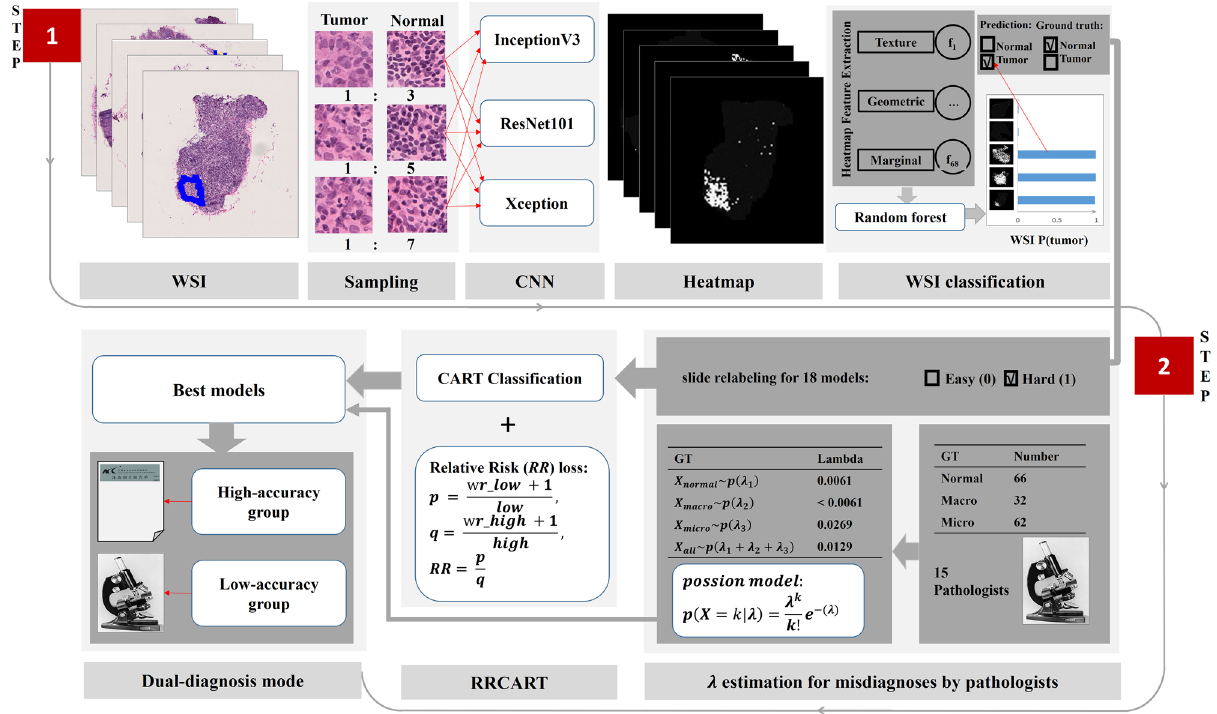
Figure 1. Overview of the Expert-DNN framework presented in this study. See Materials and Methods for complete details. There was two steps in this framework. In step 1, the patch-DNN workflow includes patch and WSI classification. Patches were extracted from tumor and normal regions of WSIs and as input data for DNN training. Patch coordination and probability generated by the model were then used for heatmap construction. A machine learning model (random forest) was trained based on the features extracted from the WSI heatmap and given a WSI-level prediction. The three sampling ratios (1:3, 1:5 and 1:7) correspond to three DNNs (InceptionV3, ResNet101 and Xception), respectively, and the experiment is repeated once. Therefore, we can obtain 18 patch-DNN models. In step 2, a Poisson distribution for the pathology experts and a RRC ART were FSs. The patch-DNN prediction result was compared with the ground truth to relabel the WSI as either easy (0) or hard (1), corresponding to the prediction result being the same as the ground truth or not. The easy